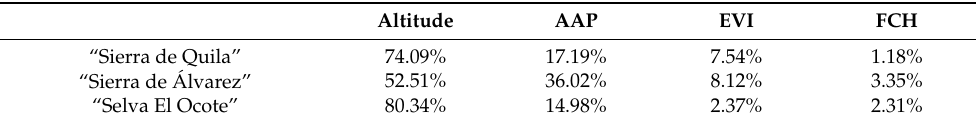
Table 4. Variable importance according to the mean decrease in impurity index by location. Altitude (m); average annual precipitation (AAP in mm); enhanced vegetation index (EVI) and forest canopy height (FCH in m). Altitude AAP EVI FCH “Sierra de Quila” 74.09% 17.19% 7.54% 1.18% “Sierra de Á lvarez” 52.51% 36.02% 8.12% 3.35% “Selva El Ocote” 80.34% 14.98% 2.37%